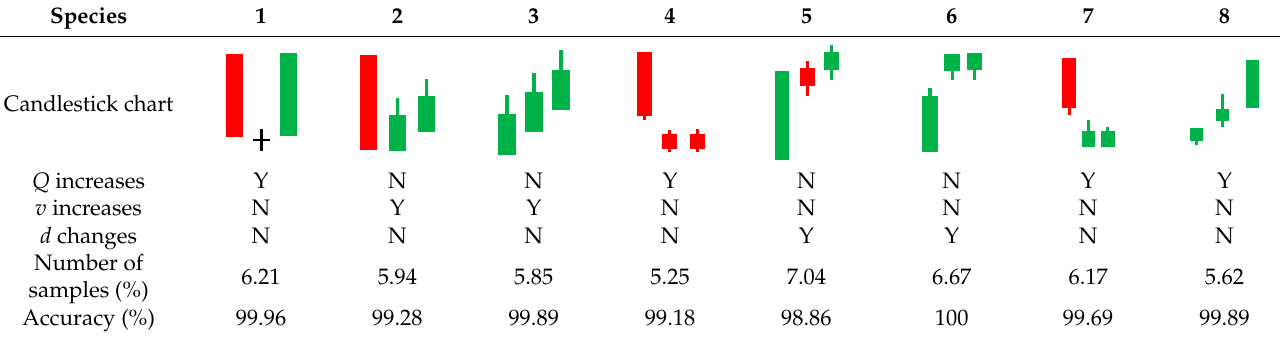
Table 4. Eight categories of the candlestick chart combinations for PM 2.5 increases. Species